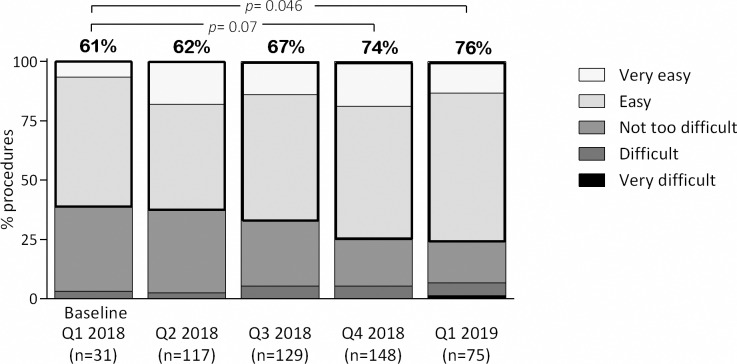
Assessment of difficulty of the LISA procedure over consecutive quarters of the study period.The figures above each column indicate the proportion of combined “easy” and “very easy” grades.